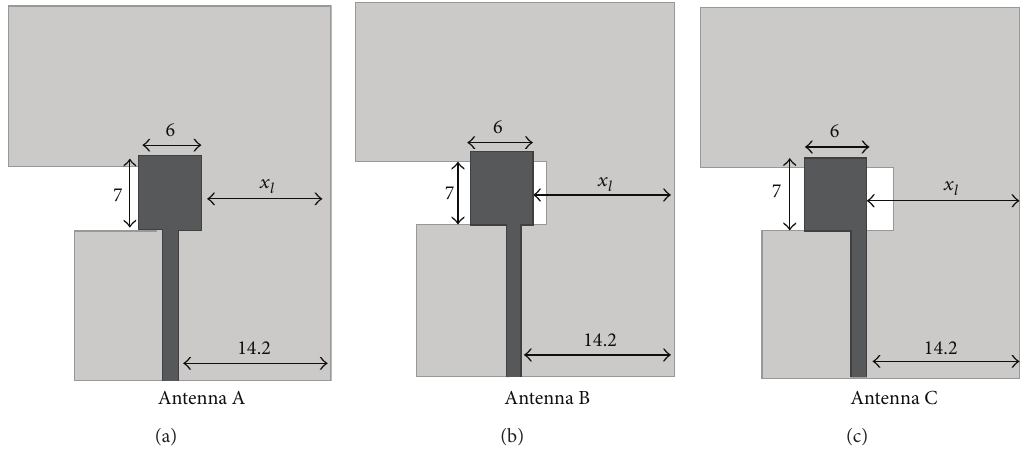
Figure 2: Design solutions adopted to excite the patch